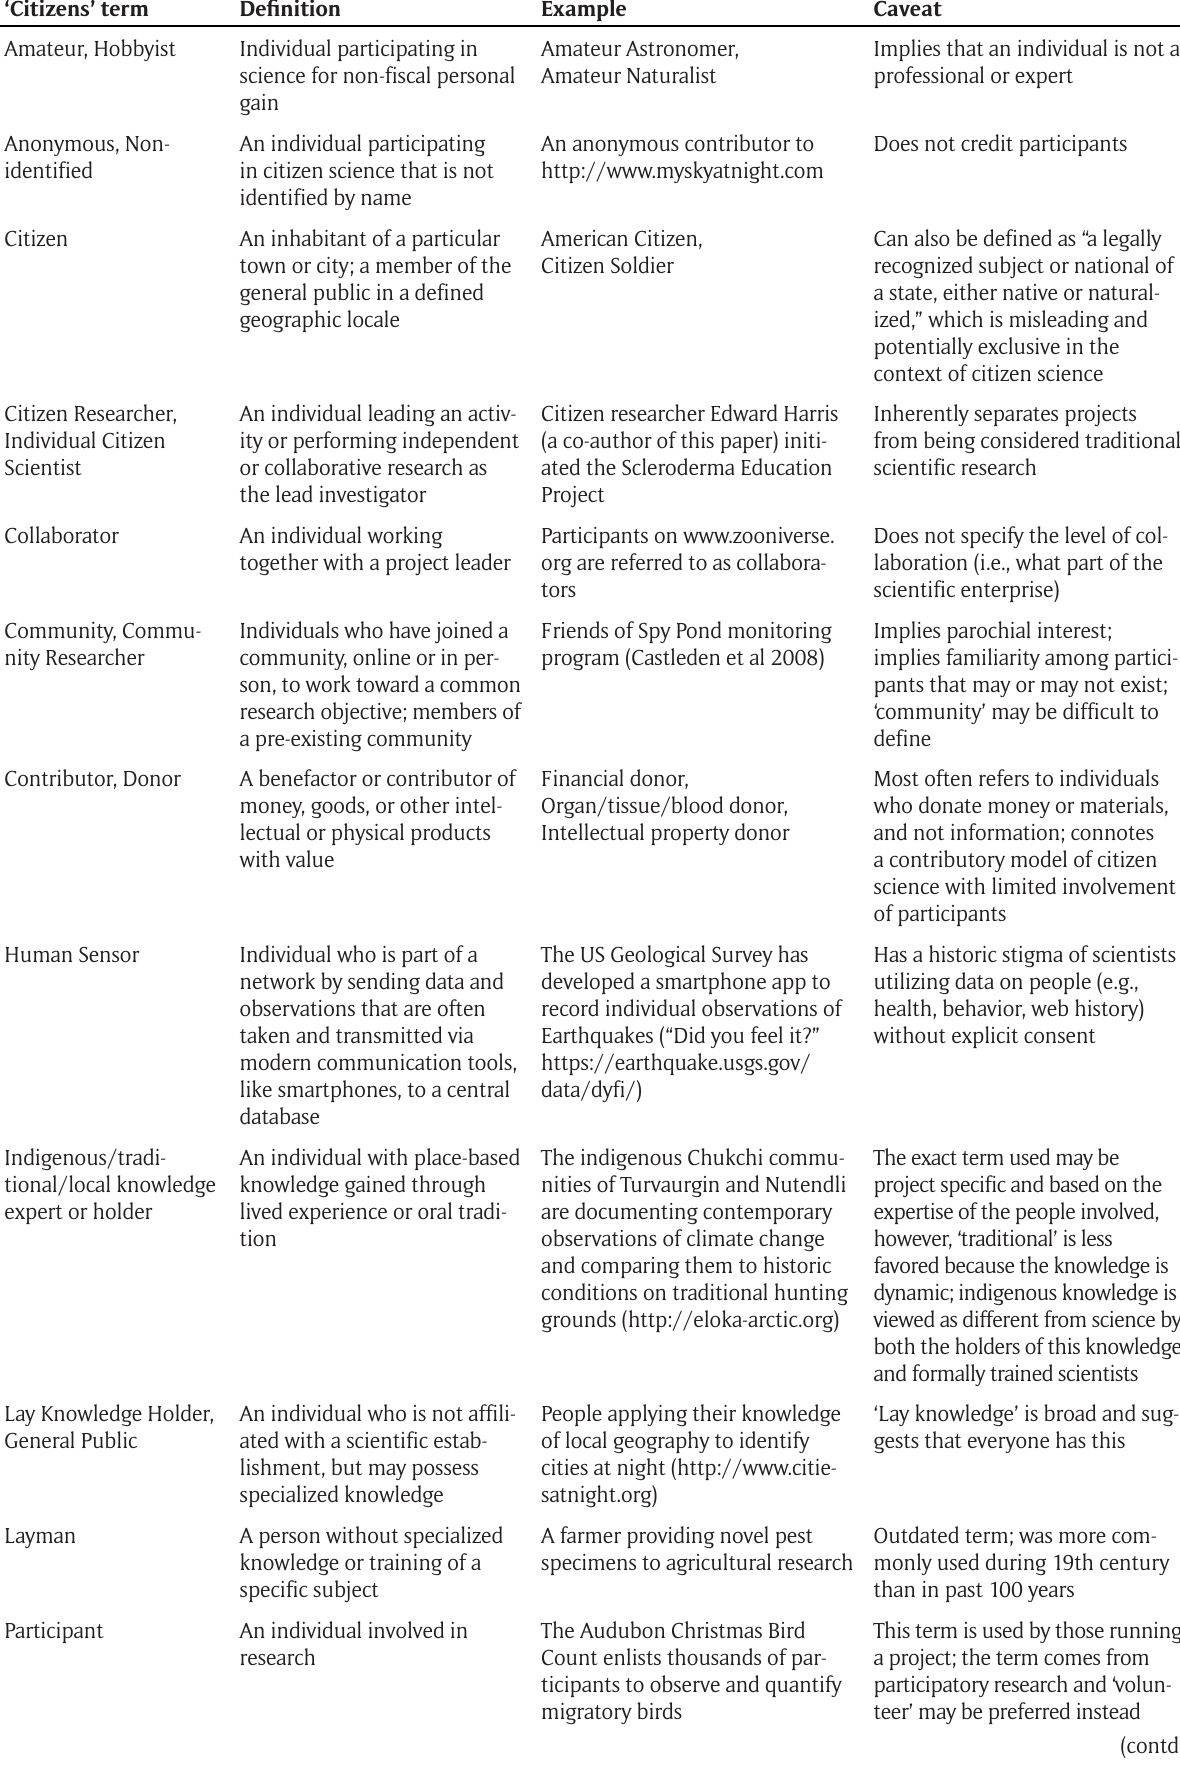
Table 4: Terms describing the ‘citizens’ in ‘citizen